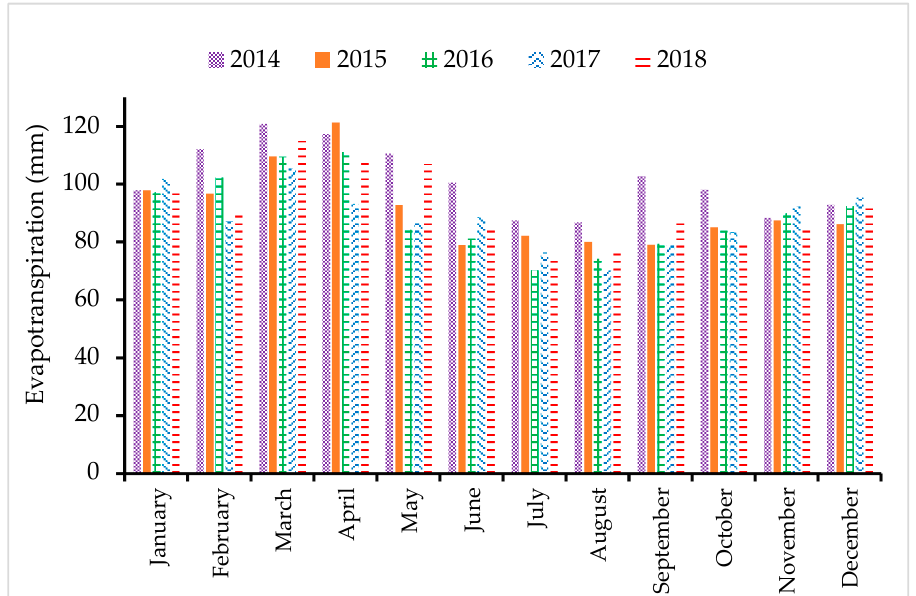
12 of 19 Figure 9. Flow duration curve (FDC) for Brantie river using 2015 to 2017 streamflow data.